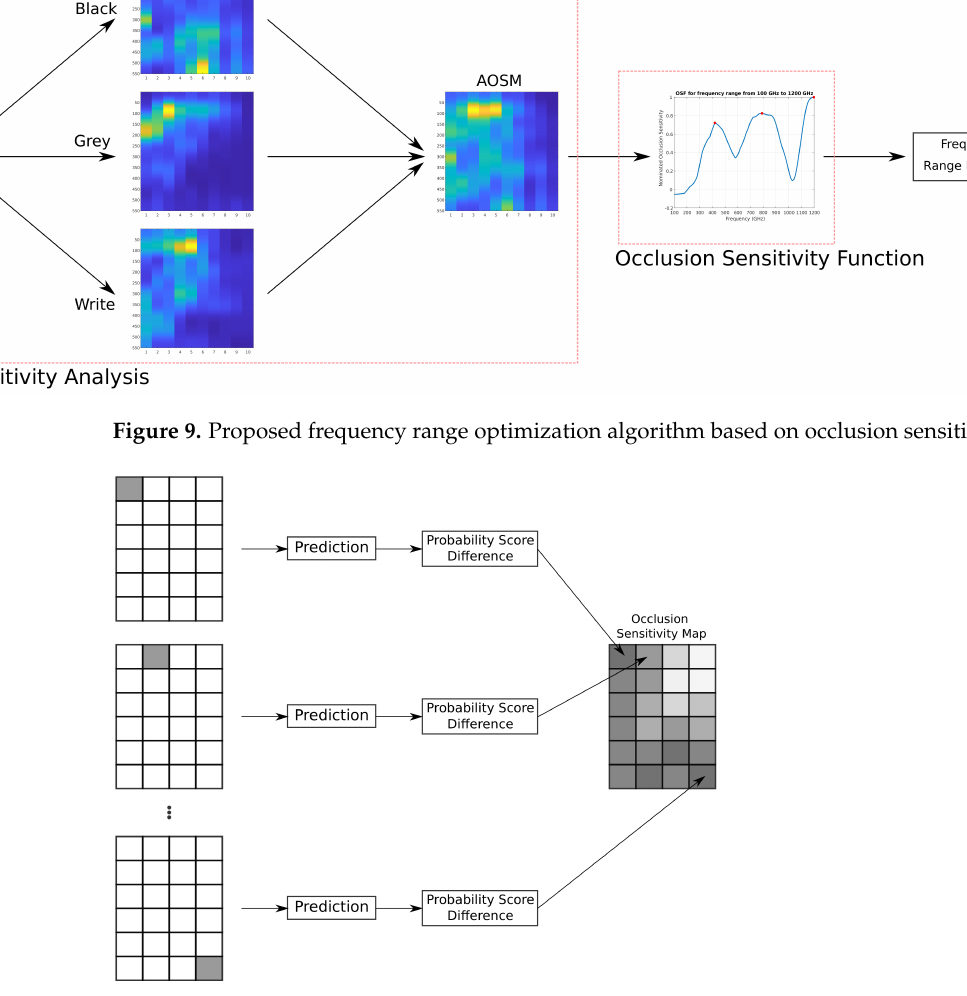
Figure 10. Occlusion sensitivity